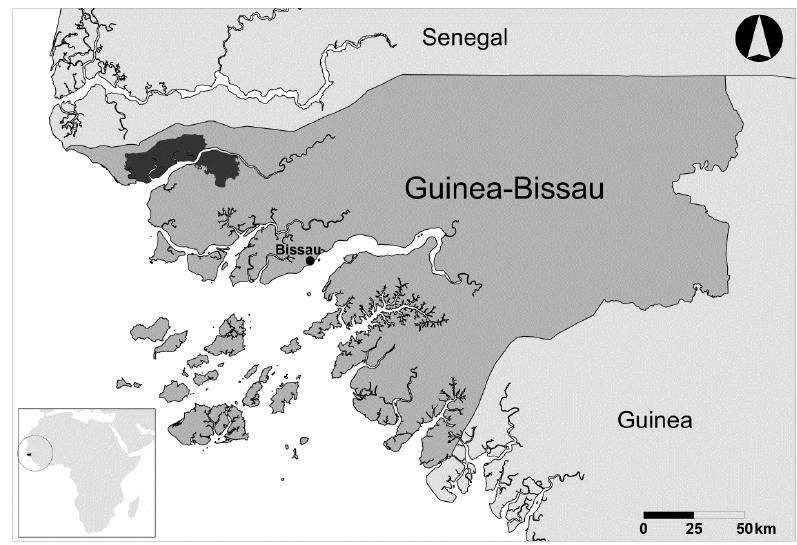
Figure 1. The study area, the Tarrafes-de-Cacheu Natural Park in Guinea-Bissau, is shown in dark grey close to the shoreline in Northern